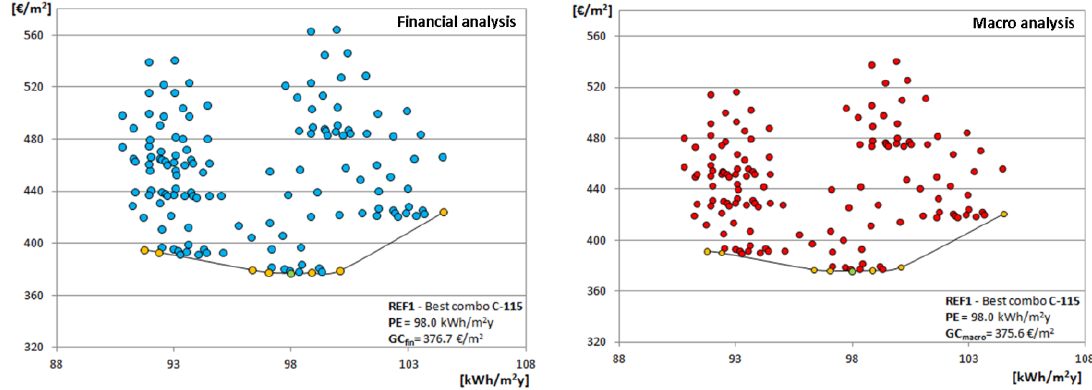
Figure 2. Cost-optimal level of reference building 1 (REF1) for financial and macroeconomic analysis.